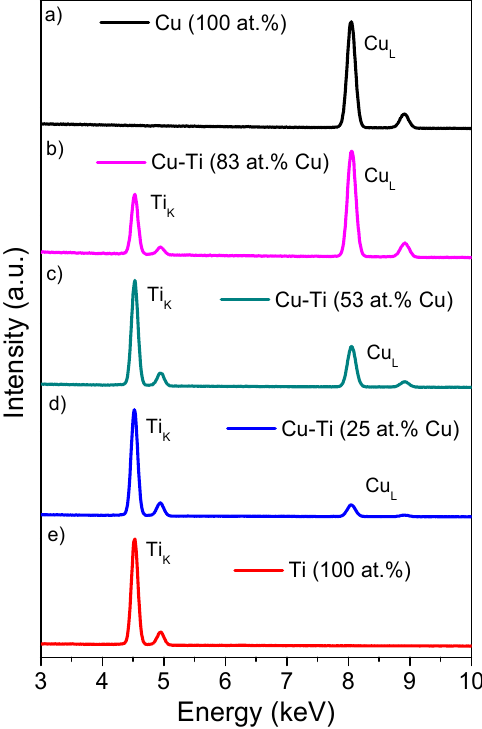
Figure 1. EDS spectra of: ( a ) Cu, ( b ) Cu 83 Ti 17 , ( c ) Cu 53 Ti 47 , ( d ) Cu 25 Ti 75 , and ( e ) Ti thin films prepared by magnetron sputtering.